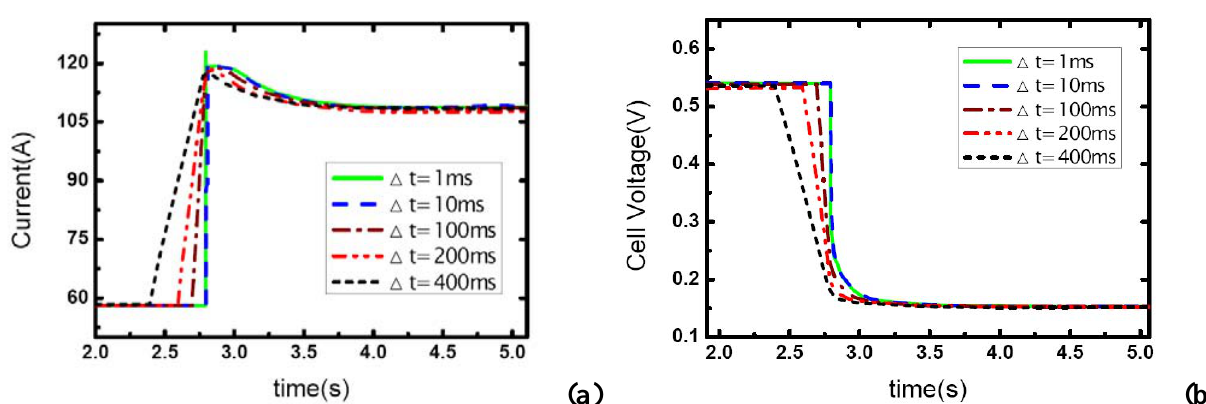
Figure 4. (a) Current change as five different step rates while λ (b) corresponding dynamic responses of